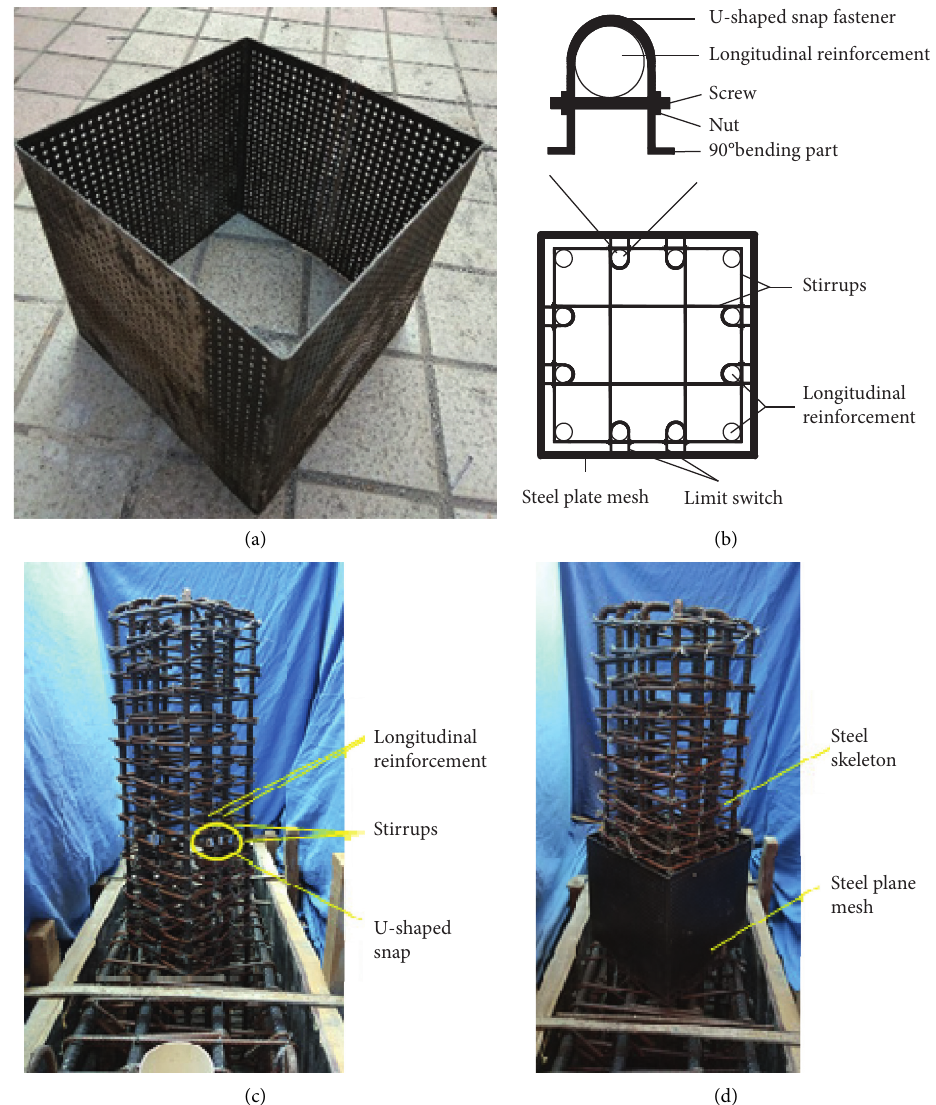
Figure 2: Details of steel skeleton production. (a) Steel plate mesh, (b) limit device floor plan, (c) steel skeleton with U-shaped snap fastener, and (d) steel skeleton with steel plate